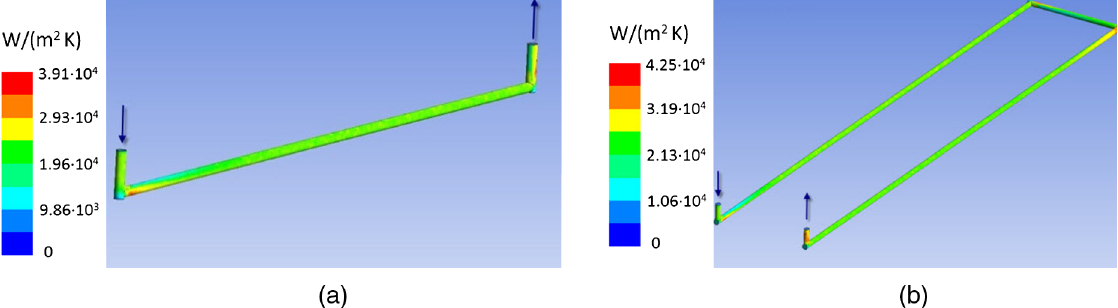
FIG. 11. CFD heat transfer coefficient